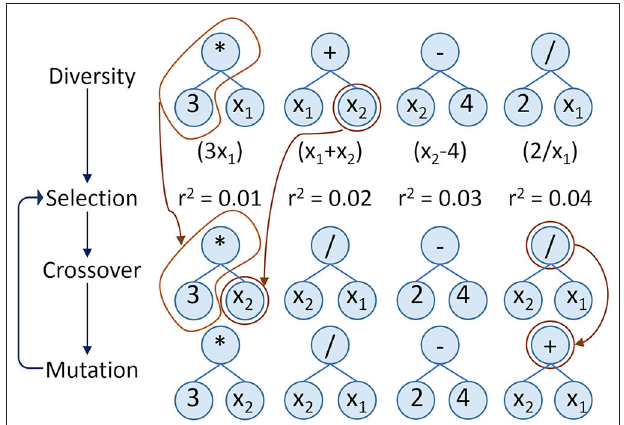
FIGURE 2 | Example of a Pareto front depicting error vs. complexity. This example reflects a symbolic regression search of the best species–area relationship for native spiders in the Azores (Portugal). The second formula is clearly the most promising, with both high accuracy (low error) and low complexity. In many occasions a single formula is not clearly best, in which case weights can be given to each of them through indices that simultaneously positively weight accuracy and negatively weight complexity (such as AIC or BIC) and/or multiple formulas presented as possible outcomes. on any building block) is added to the process after